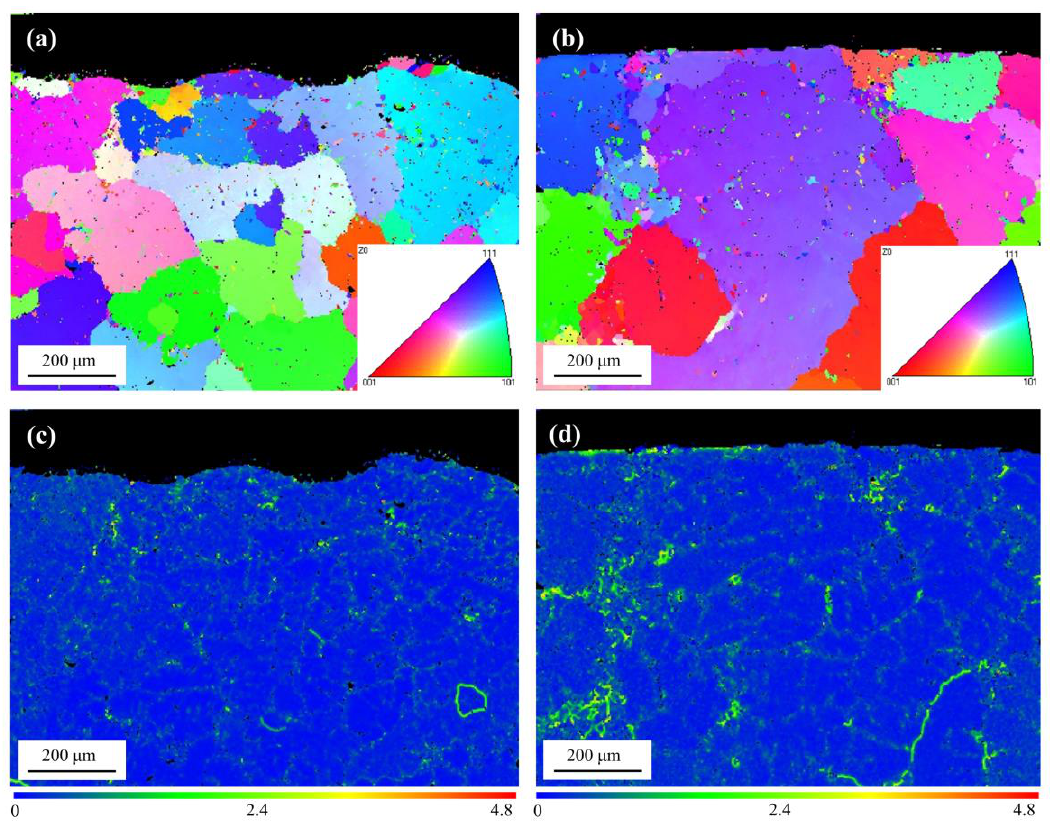
Figure 13. IPF mappings for cross-sections of the ( a ) mechanical lapping sample and ( b ) laser- cleaned sample, and LM mappings for the cross-sections of the ( c ) mechanical lapping sample and ( d ) laser-cleaned sample.